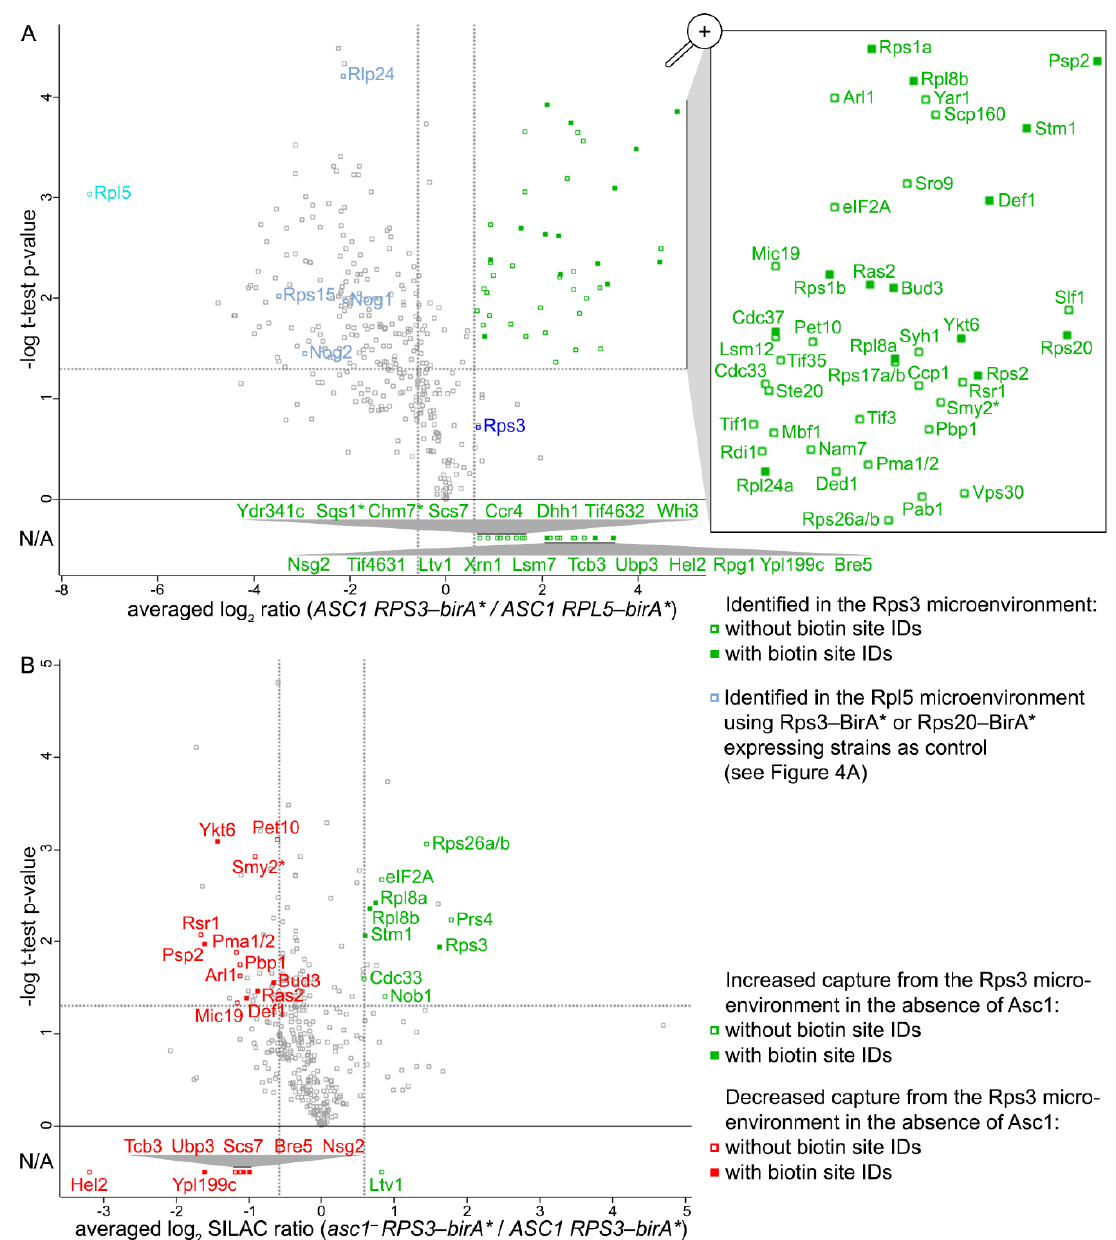
Figure 3. Proteins occurring proximal to Rps3 and their Asc1-dependence. Volcano plots show the averaged log 2 SILAC ratios for ( A ) ASC1 + RPS3-birA* ( light SILAC) to ASC1 + RPL5-birA* ( medium SILAC) and ( B ) asc1 — + RPS3-birA* ( heavy SILAC) to ASC1 + RPS3-birA* ( light SILAC) on the x-axes and the -log 10 ( p -value) of the t-test on the y-axes. Gray dotted threshold lines indicate a p -value of 0.05 (horizontal) and a log 2 SILAC ratio of 0.585 or −0.585 (vertical). Proteins with two instead of three quantification values (w/o p -values) that passed the threshold of two values ≥ 0.585 are depicted below the horizontal 0-value line with their averaged log 2 SILAC ratios (L/M in A and H/L in B). Not applicable (N/A) on the y-axis indicates that no t-test was performed for these proteins and thus no p -value is available. For proteins highlighted with an asterisks (*), no information about their protein abundance was obtained from the proteome data. For all other proteins that are highlighted in red or green, at least one quantification value was obtained from the proteome analysis. Gray squares represent proteins not passing the set criteria for proximity ( A ) or Asc1-dependence ( B ). For details see Tables S1–S5.